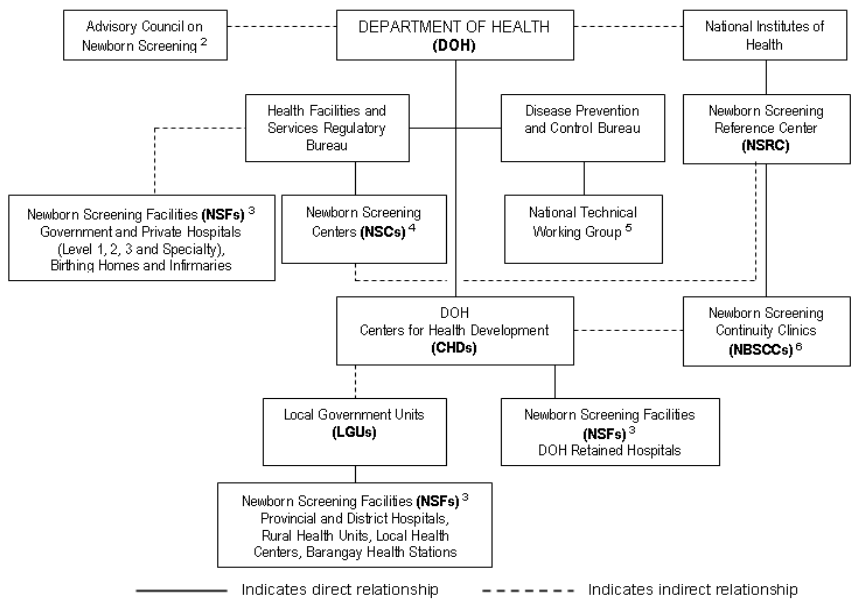
Figure 2. National Comprehensive Newborn Screening System 1 (NCNBSS) Functional Chart.